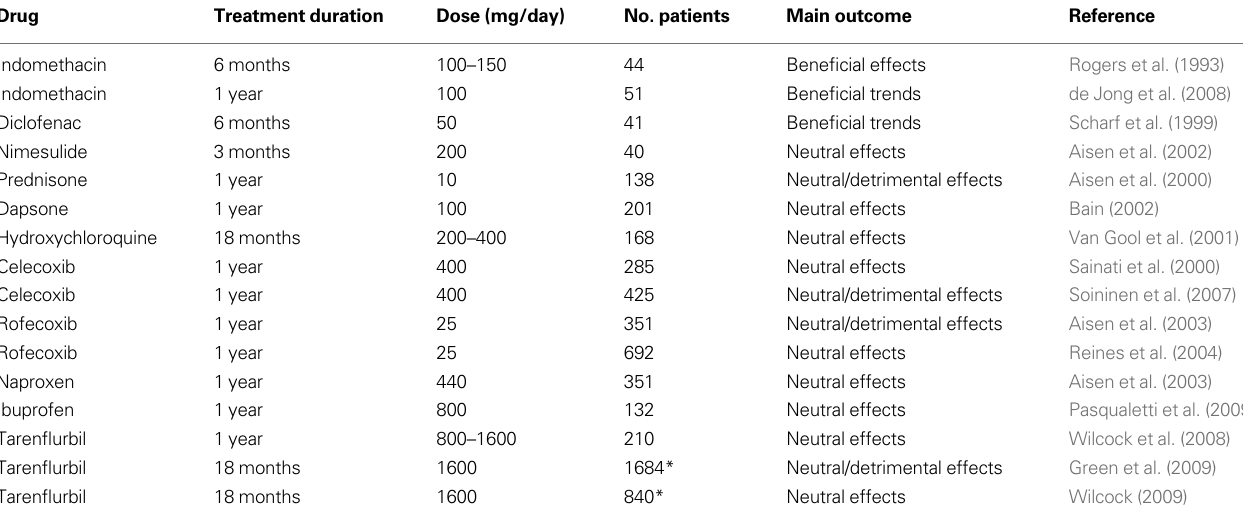
Table 2 | Double-blind, randomized, placebo-controlled trials of anti-infl ammatory drugs in patients with mild-to-moderate AD. Drug Treatment duration Dose (mg/day) No. patients Main